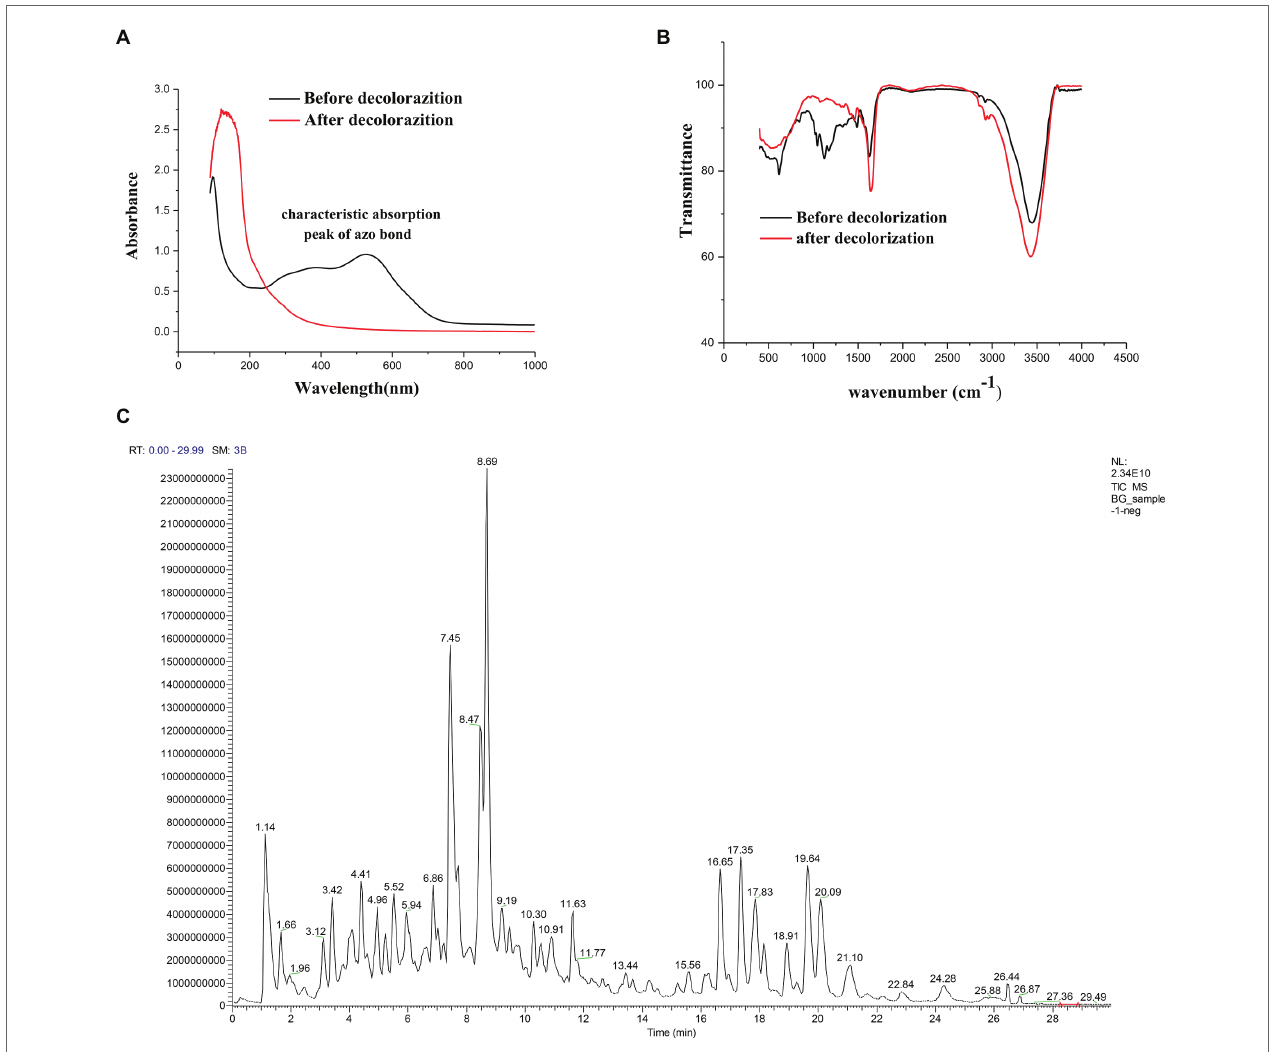
FIGURE 3 | (A) UV–Vis spectrum analysis of 600 mg/l Direct Black G (DBG) medium after decolorization of extremely complex halotolerant/halophilic flora. (B) Fourier infrared spectroscopy analysis of 600 mg/l DBG medium after decolorization of extremely complex halotolerant/halophilic flora. (C) LC–MS analysis of 600 mg/l DBG medium after the decolorization of extremely complex halotolerant/halophilic